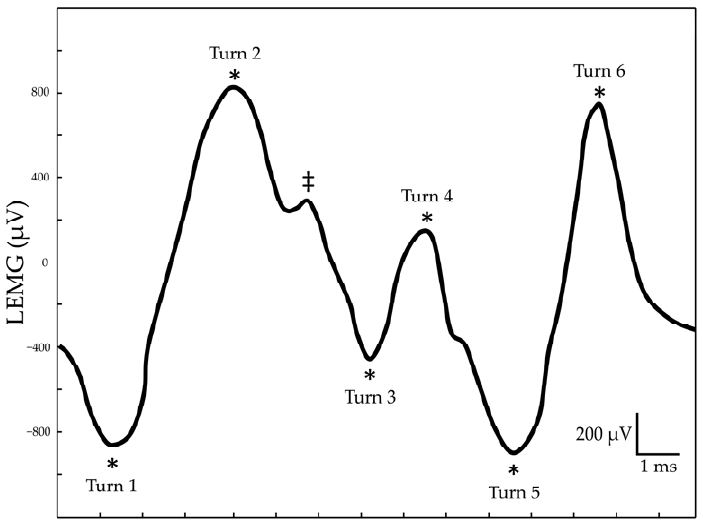
Figure 2. Example of a turns/s calculation in a 15 ms LEMG segment. A “turn” occurs at each peak of the measured signal (asterisks). The total number of detected turns was six, as the peak observed between Turn 2 and Turn 3 (double dagger) was below the threshold of 100 µ V and therefore excluded from calculation.